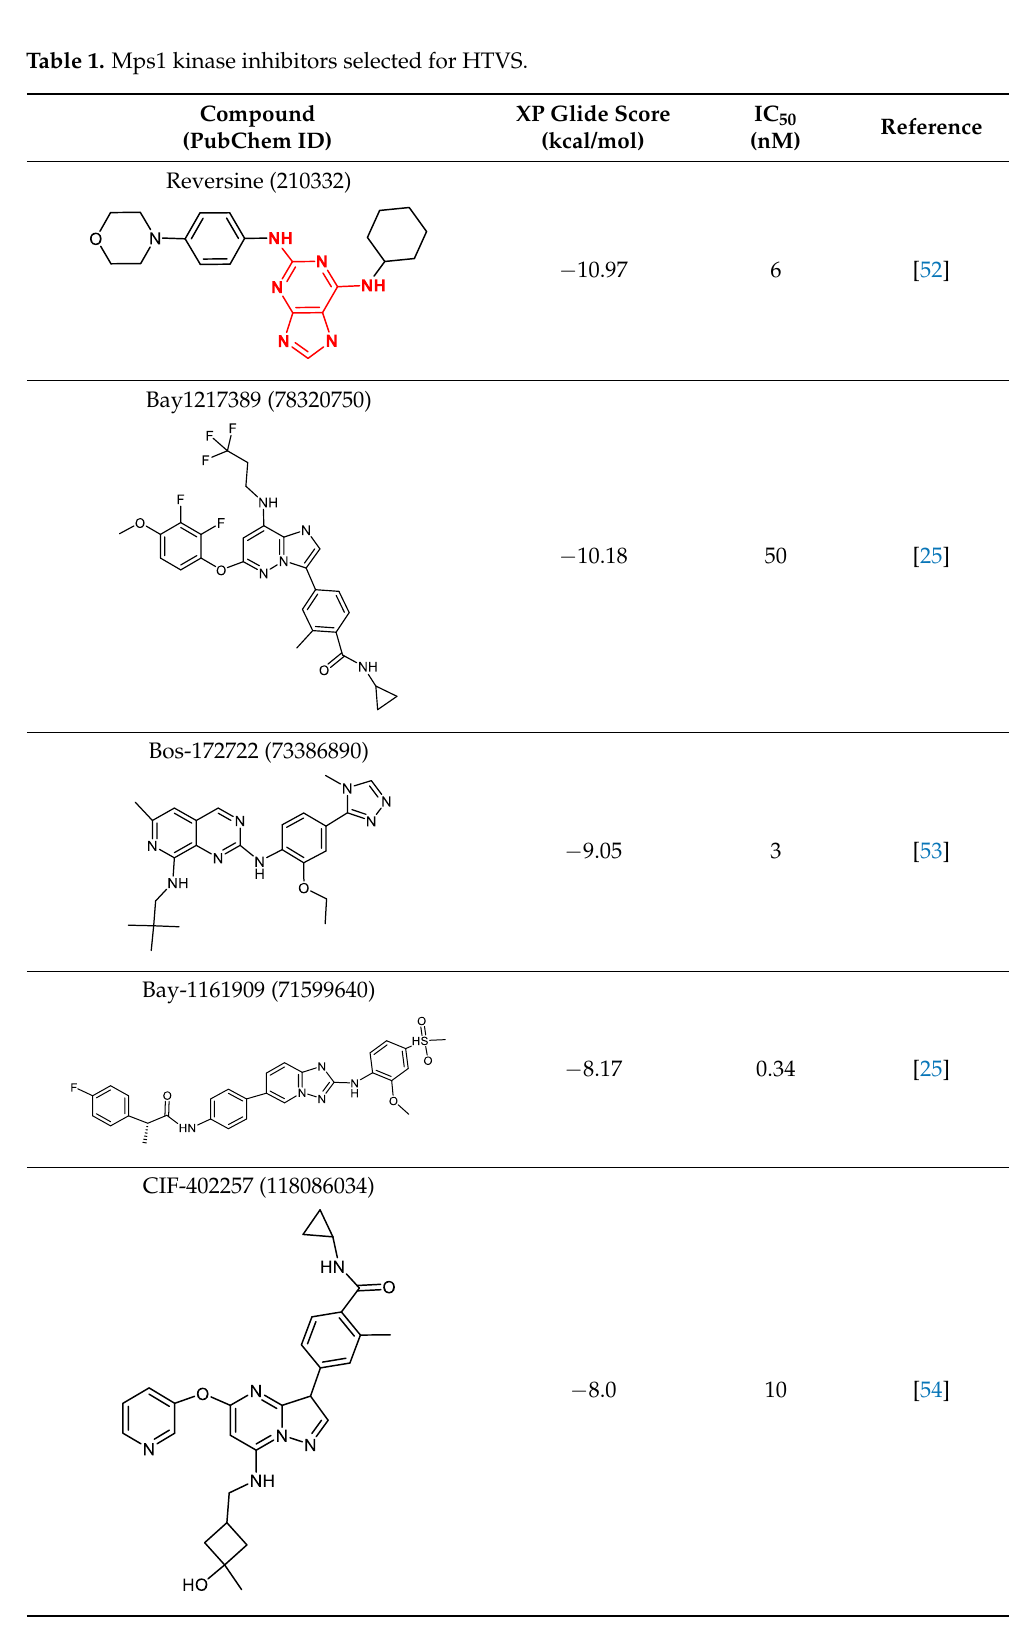
Figure 2. Reversine can establish polar interactions with the Mps1 kinase domain. However, reversine is a small molecule first reported as an inhibitor of Aurora B ki- nase that abolished the Aurora B-dependent phosphorylation of histone H3. Hence, the search for more selective inhibitors of Mps1 remains important. To this aim, we first car- ried out the exploration of a chemical library of compounds that are structurally related to reversine (CID 210332). For this, the PubChem database with a 0.9 Tanimoto similarity index was screened. Upon conformational analyses, all the compounds were subjected to the high-throughput virtual screening (HTVS) XP Glide docking protocol. Compounds with docking Glide scores better than −9.0 kcal/mol, predicted specific interactions with Gly605-Glu603 residues, and significant structural diversity were considered the most promising Mps1 kinase ligands (Table 2). Table 2. XP Glide docking score and type of contacts with Mps1 kinase residues of selected com- pounds. Compound ID 2D